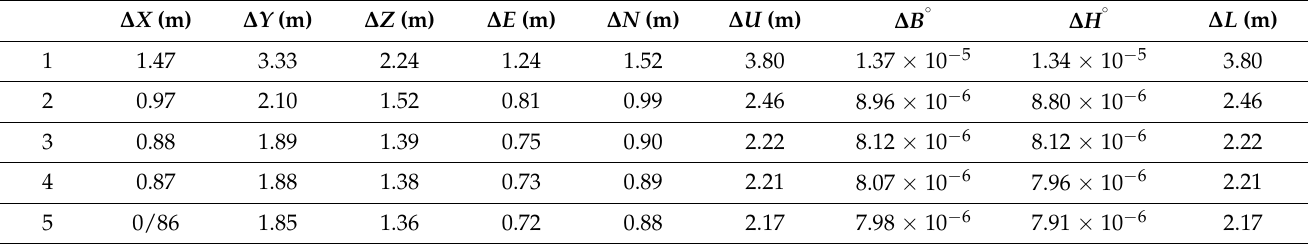
Table 4. The std of the position error for